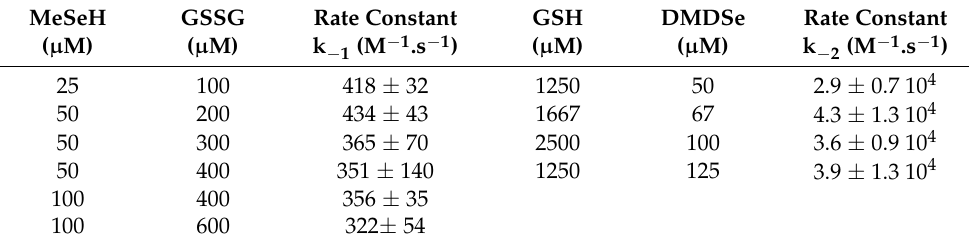
Table 2. Rate constants deduced from stopped-flow experiments performed with mixtures of MeSeH and GSSG (left) or GSH and DMDSe (right). Means and standard deviations were calculated from at least three replicate measurements.